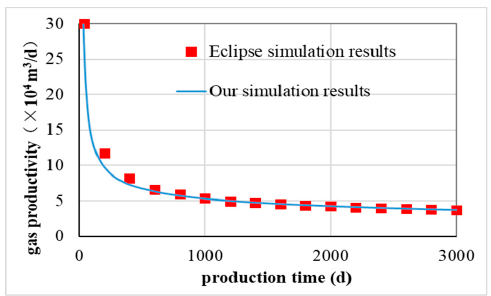
Figure 5. Comparison of the gas production calculated using finite volume method and commercial software Eclipse.